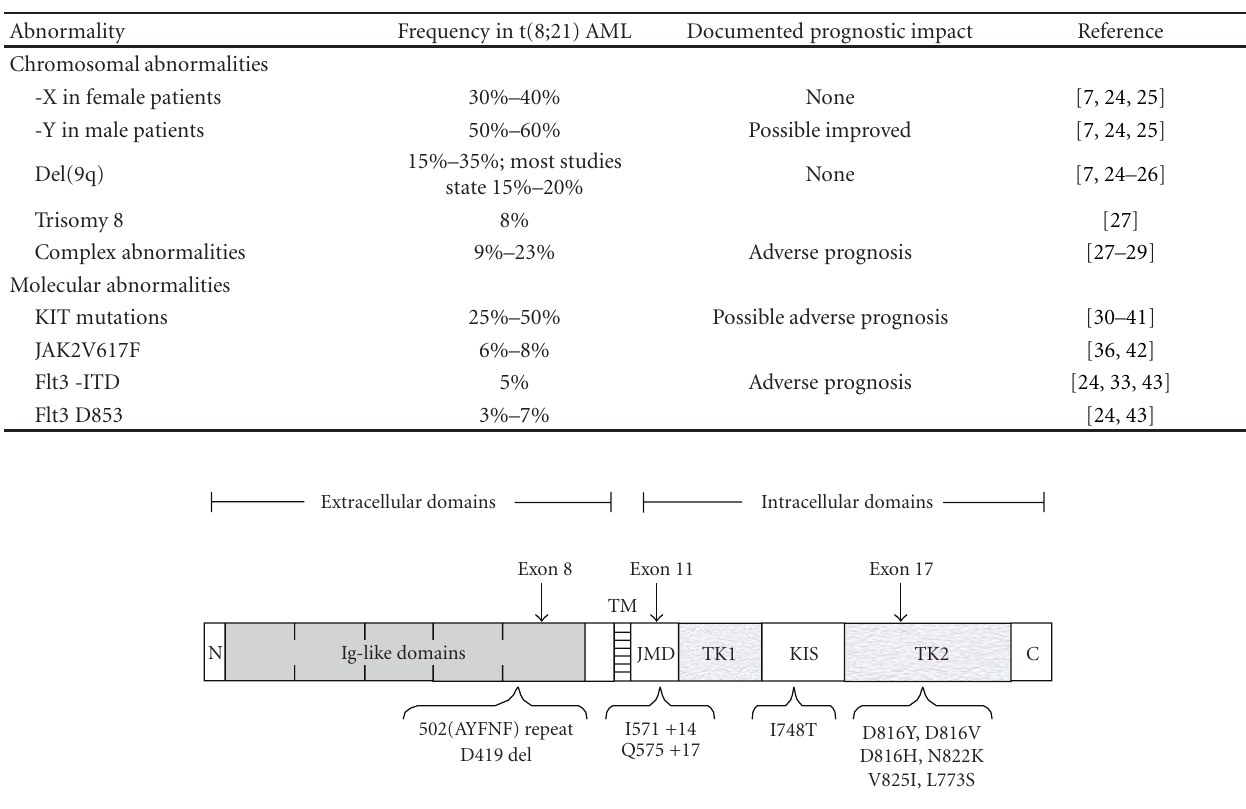
Table 1: Genetic abnormalities commonly detected in combination with t(8;21).